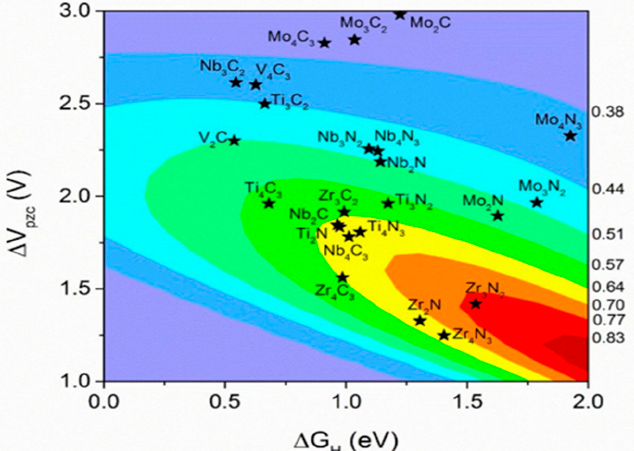
Figure 9. Color map of the relationship between the charge storage per formula unit against the shift in the V PZC and H 2 adsorption free energy ( Δ G H ). The applied potential ranged from − 1 to 1 V vs. standard Hydrogen Electrode (SHE). Reproduced with permission from [ 82 ] . Copyright ACS, 2019.